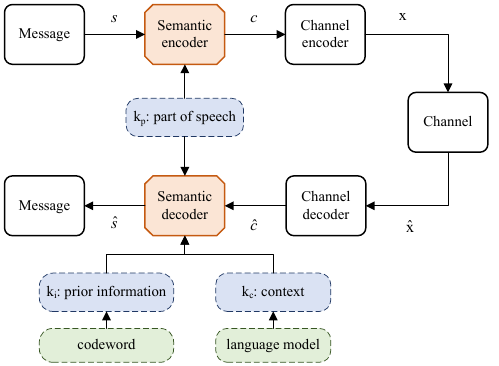
Figure 1. The semantic communication